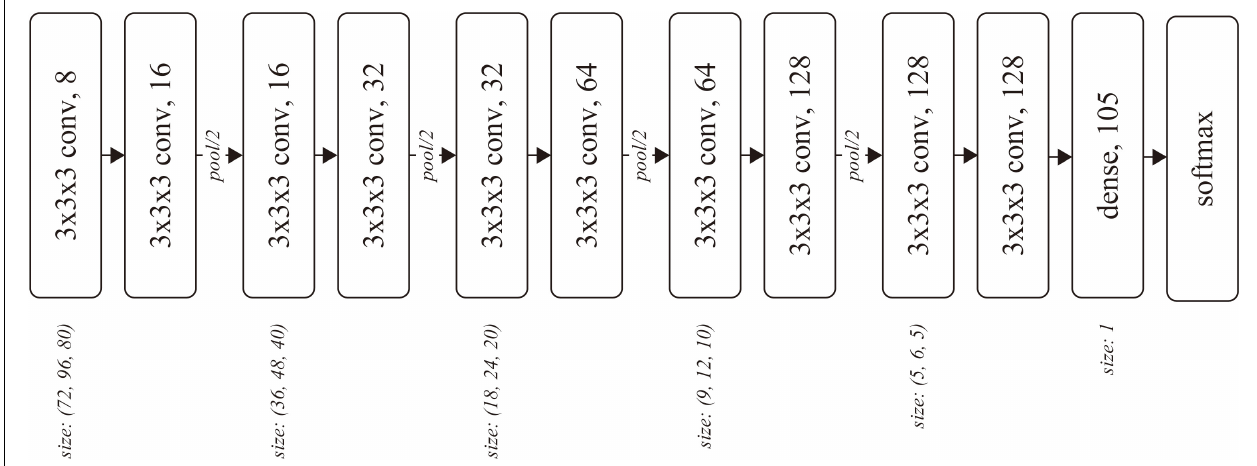
FIGURE 1 | Network architecture. Each rounded square represents a layer with the weight parameters. The number after the comma denotes the number of channels for the